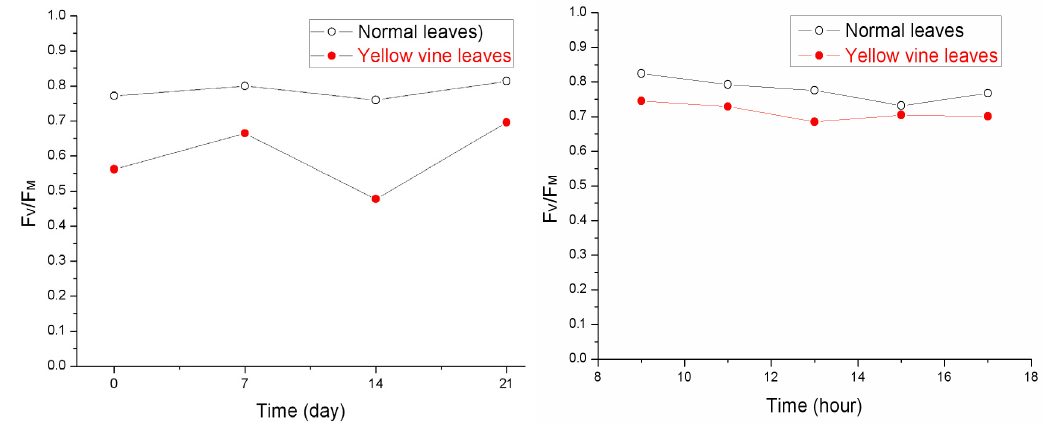
Figure 3. Photosynthetic activity of cranberry leaves obtained during a period of three weeks ( left ) and of one day ( right ): ( a ) PS II maximum quantum yield; ( b ) Photosynthetic performance index; ( c ) Size of quinone pool. (From [59], with permission from the American Society for Horticultural